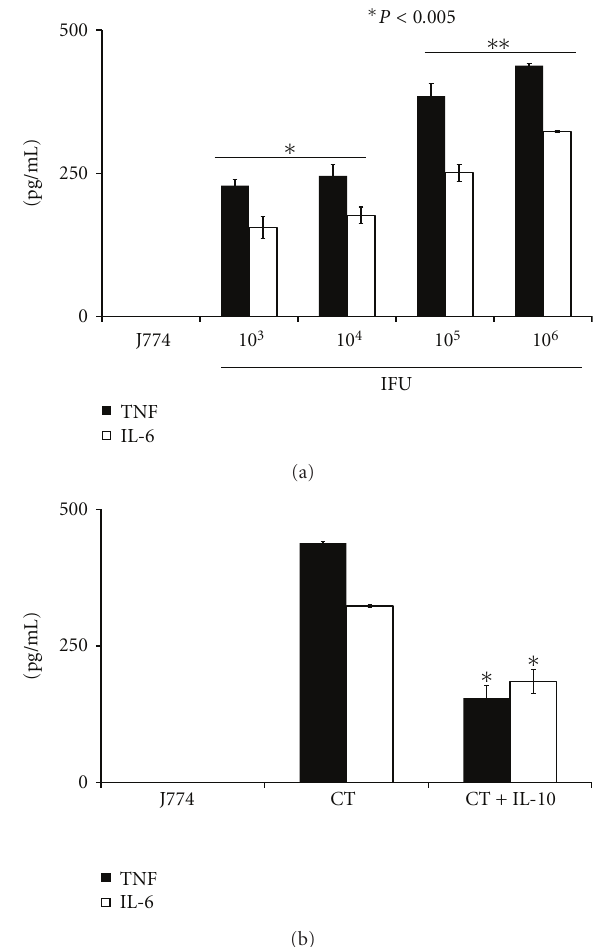
Figure 6: UV-inactivated C. trachomatis induction of TNF and IL-6 levels in mouse J774 macrophages are downregulated by exogenous IL-10. J774 cells (10 5 cells/well) were stimulated for 24hr with various concentrations of UV-inactivated C. trachomatis . The production of TNF and IL-6 was quantified in cell-free culture supernatants using cytokine-especific ELISAs. Shown are the dose- dependent TNF and IL-6 responses (a) and the downregulatory e ff ect of IL-10 on these cytokines (b). Asterisk indicates significant di ff erence ( P < 0 . 005), and P values were calculated by use of Stu- dent’s t -test. Each bar represents the mean ± SD of samples run in triplicates. The data are representative of two separate